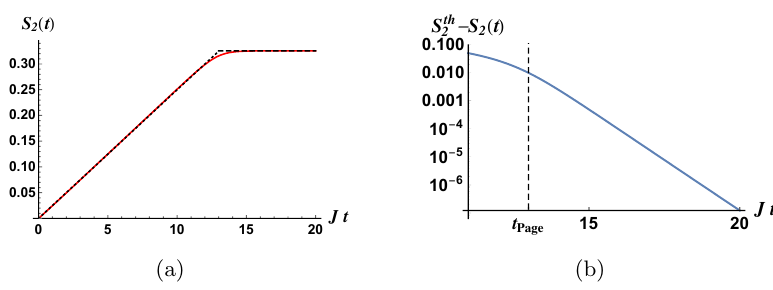
Figure 4 . (a) The Page curve of the second R(cid:19)enyi entropy per Majorana fermion S 2 from the master equation. We start from the initial distribution given in (3.22). We choose N = 66, q = 4, and V = J = 0 : 2. The dotted line is the (cid:12)rst line in (3.34), and the dashed line is S th where the (cid:12)nite N correction is included. (b) A log linear plot of S th It indicates an exponential e (cid:0) (cid:21)t behavior, consistent with the log N scrambling time discussed in section